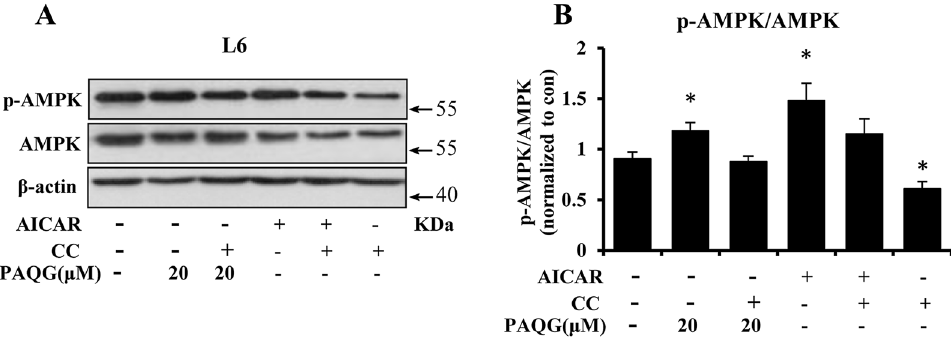
Fig. 5 PAQG promotes phosphorylation of AMPK. a The effects of PAQG in the absence or presence of AICAR or compound C on the protein expression of AMPK and p-AMPK in L6 cells. b The results